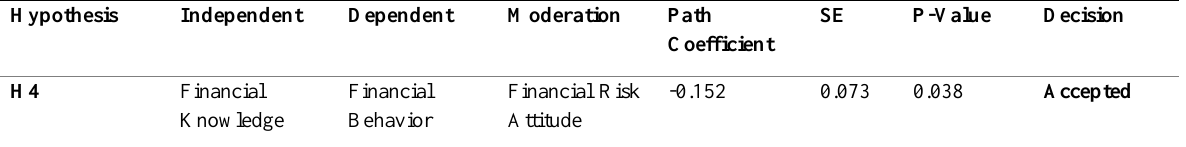
Table 6: Moderation